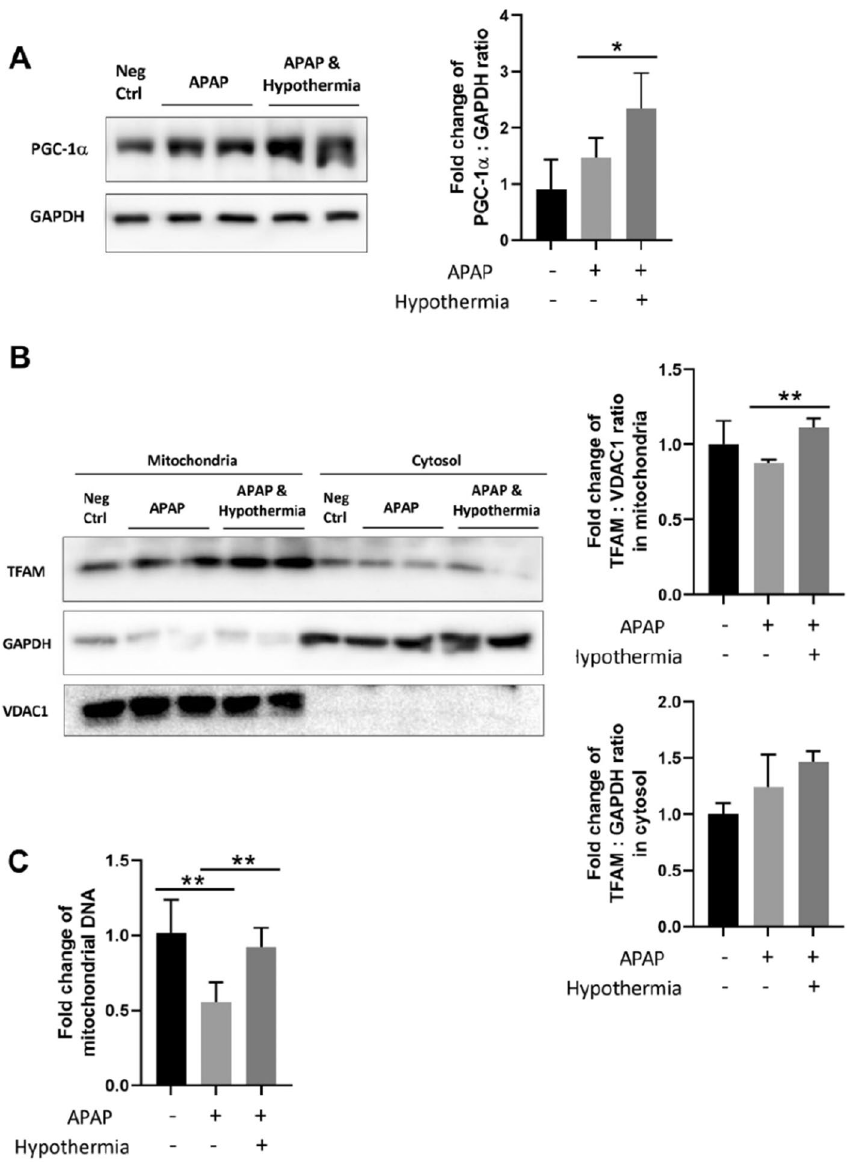
Figure 7. Effect of pulsed cooling on mitochondrial biogenesis in mice. Western blotting was performed to investigate the protein expression of (A) PGC-1α in whole cell lysate and ( B ) TFAM in mitochondrial and cytosolic fractions. For whole cell lysate, GAPDH was used as the housekeeping protein; for mitochondrial and cytosolic fractions, VDAC1 and GAPDH was used as the housekeeping proteins respectively. Densitometric analysis was performed for all western blots and normalized against the negative control i.e. mice without both APAP administration and pulsed cooling. ( C ) A relative change in the mitochondrial DNA levels was also determined with real-time RT-PCR. Data are presented as mean ± SD (n ≥ 3) where one-way ANOVA was used to make comparison across different treatment groups and post-hoc tests were subsequently carried out with correction for multiple comparisons using Sidak’s method. * P < 0.05; ** P <